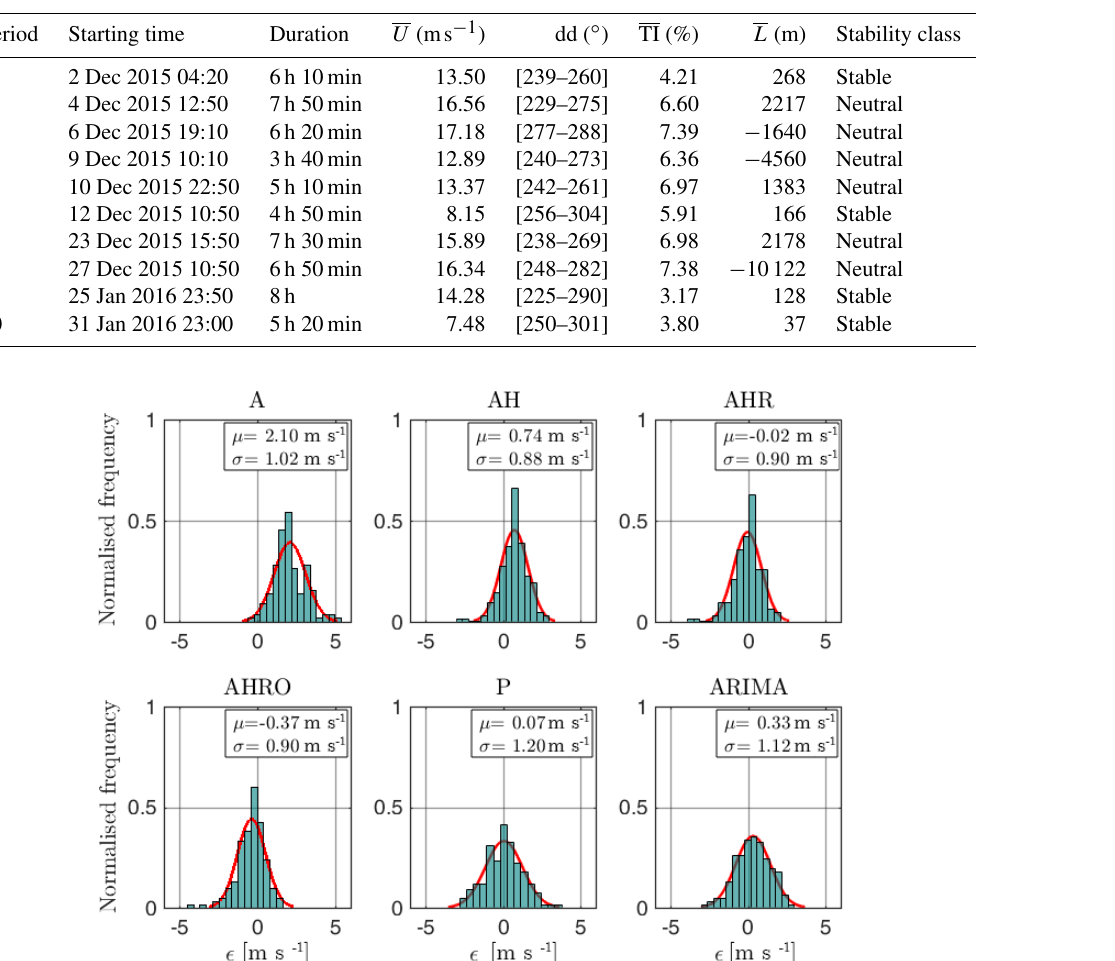
Table 2. Computed statistics of wind speed ( U ), wind direction (dd), turbulence intensity (TI) and Obukhov length ( L ) for all evaluated periods, based on the Høvsøre met mast at 100m.